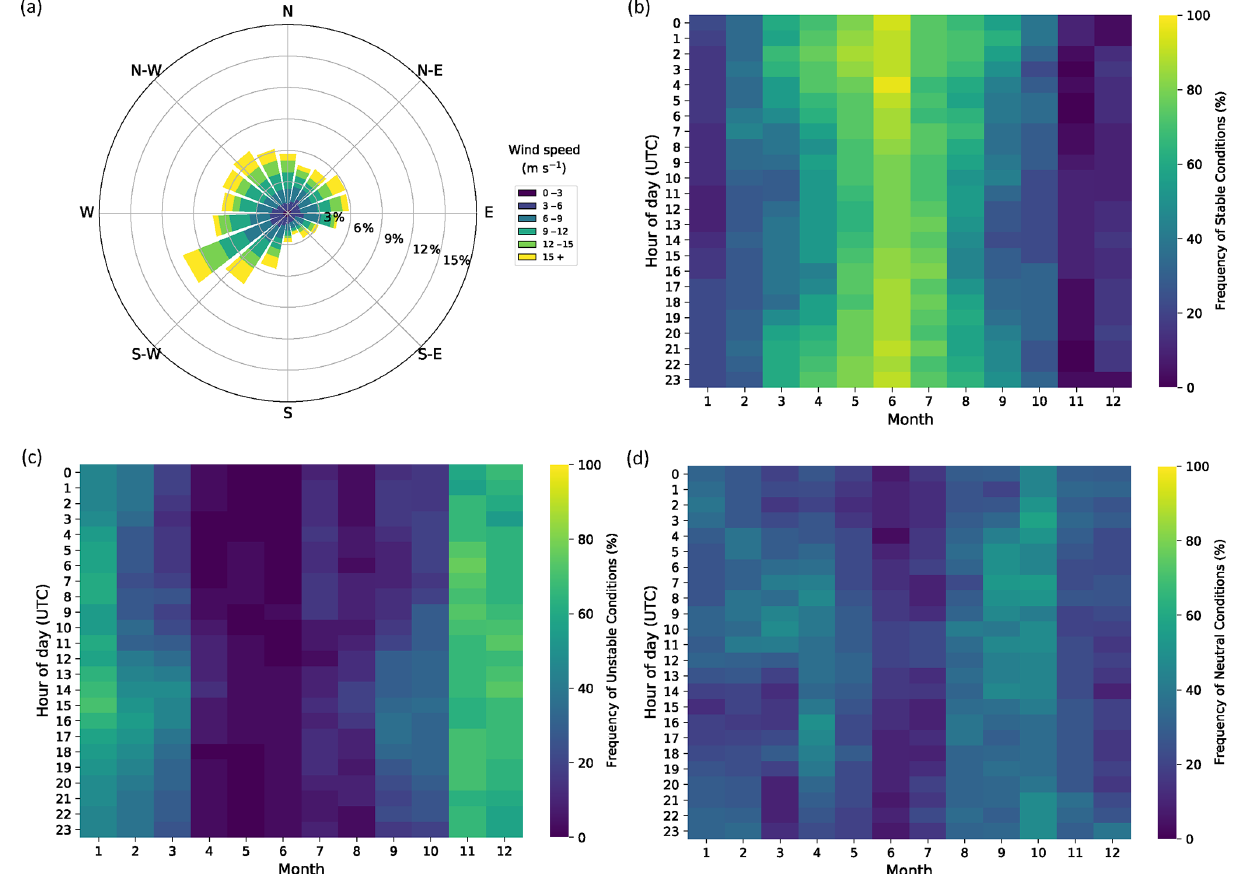
Figure 3. (a) Wind rose showing the distribution of wind speeds at 100ma.g.l. for September 2019 to August 2020, using observations from the E05 floating lidar. (b) The 24 × 12 heat map of the frequency of stable conditions at the E05 lidar location, classified in terms of the WTK-LED-based bulk Richardson number calculated between 0 and 200ma.s.l. (c) Same but for unstable and (d) neutral conditions. Results from the E06 lidar are included in the